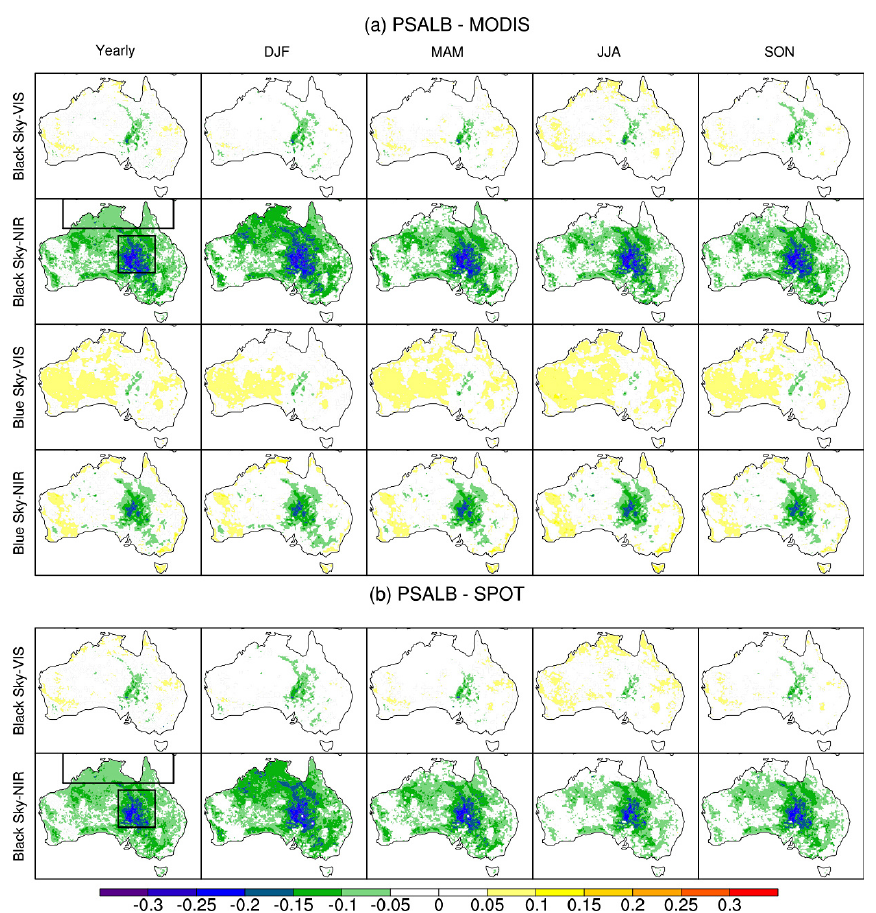
Figure 6. Same as in Fig. 5 but for the PSALB experiment. The northern and central boxes in the black-sky NIR yearly panel show the regions for which a time series is plotted in Fig.